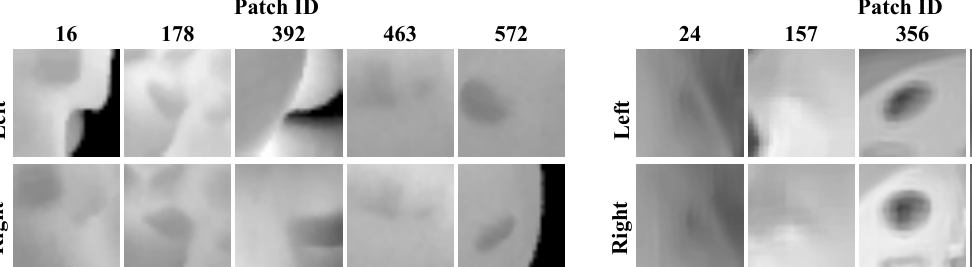
Figure 4. Examples of cropped images patches from MVSIR dataset.